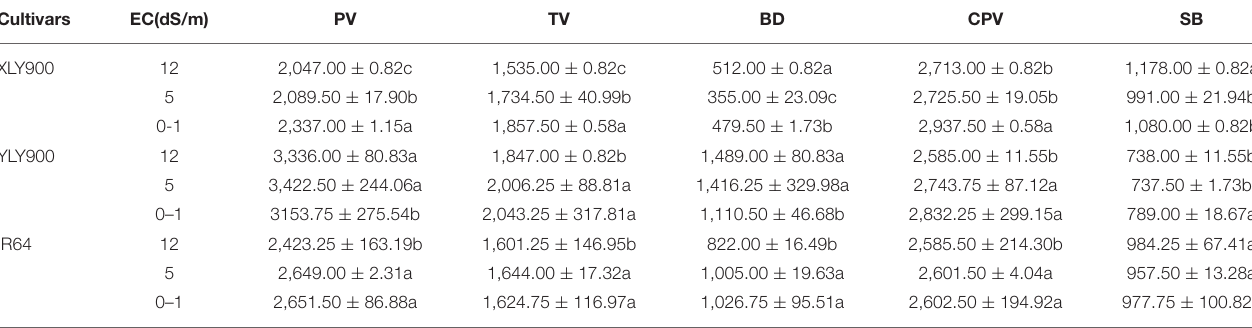
TABLE 4 | Effects of salt stress on starch pasting properties. Cultivars